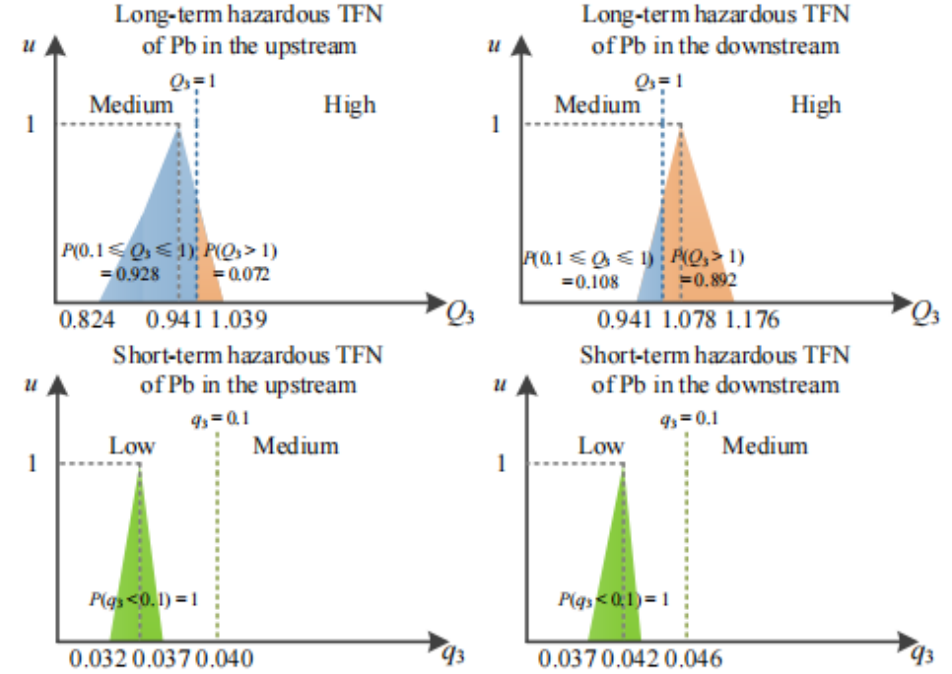
Figure 11. Hazardous TFNs of Pb after dam construction.